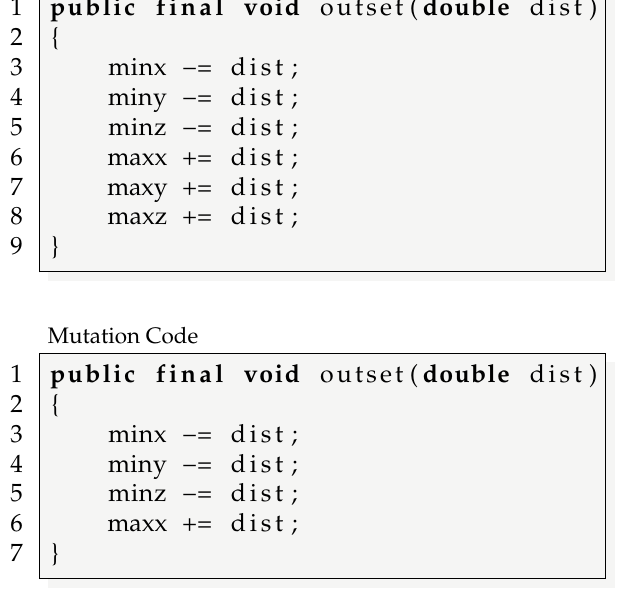
Figure 4. Example of seeding a defect in a function outset()